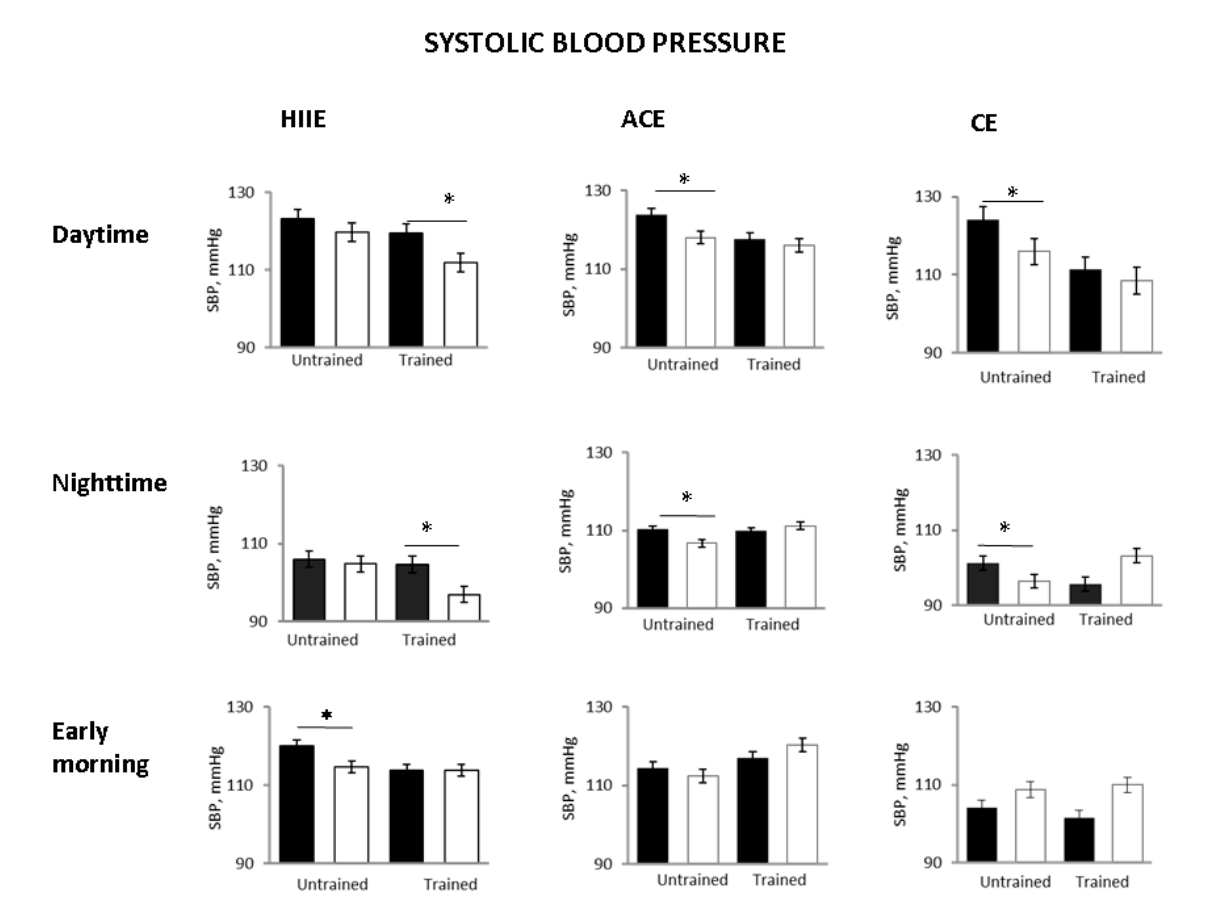
Figure 3. Post-exercise changes in ABPM systolic BP in the three study groups in the different 24-h periods before (black bars) and after (white bars) a single exercise session in the untrained and trained status. HIIE, high intensity interval exercise, ACE, aerobic continuous exercise; CE, combined exercises * p < 0.05 vs. pre exercise.